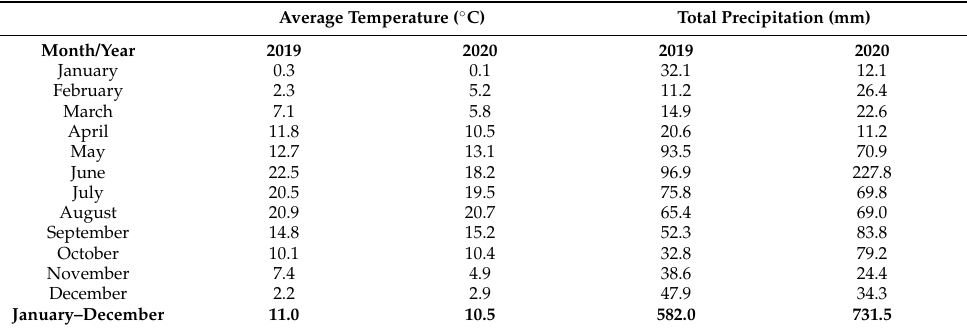
Figure A1. Meteorological conditions in the study area during the day plus the 30 days preceding soil sampling in 2019 and 2020; the bars show daily precipitation; the lines show daily mean temperatures. Table A2. Meteorological data from the nearest climatic station to the study area during the years of soil sampling (source: the Czech Hydrometeorological Institute).